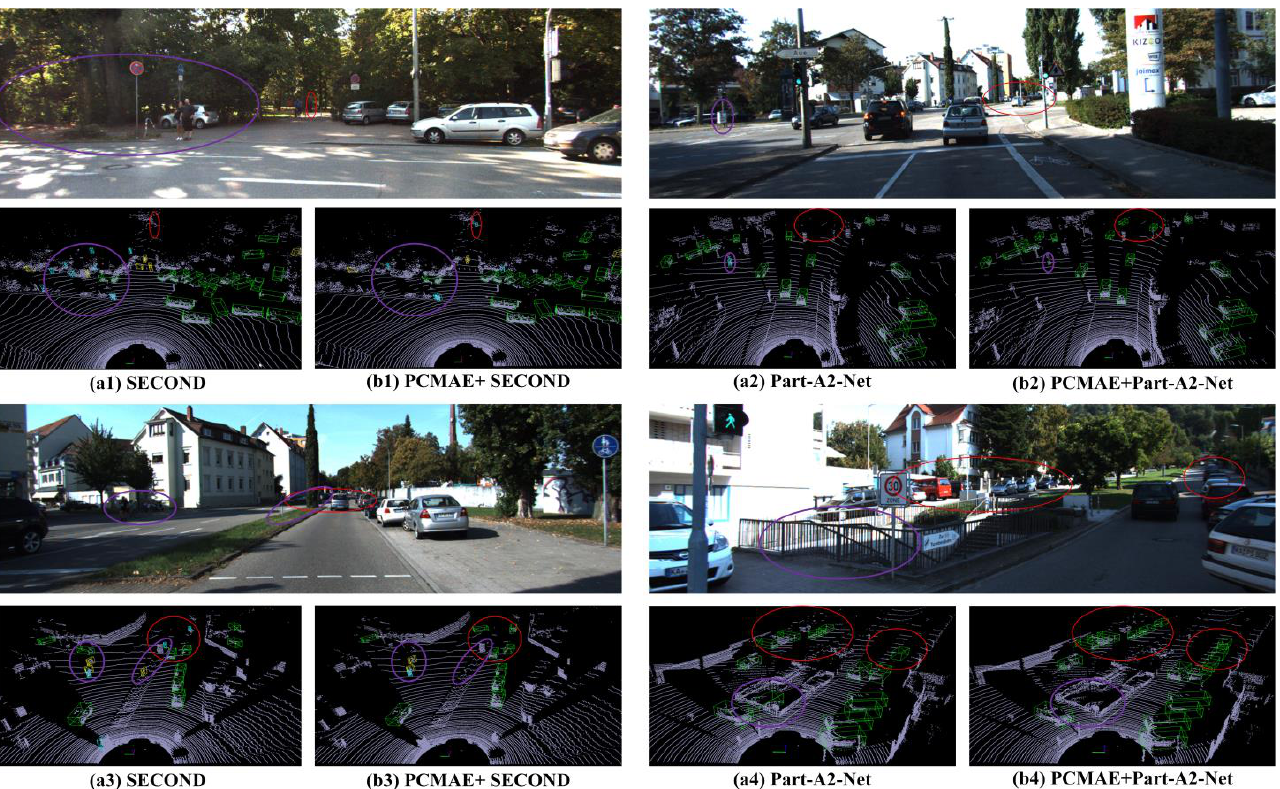
Figure 11. Qualitative results on the KITTI test set. ( a1 – a4 ) Detection results of the original algorithm. ( b1 – b4 ) The optimized algorithm detection results. Green boxes represent cars. Blue boxes represent pedestrians. Yellow boxes represent cyclists. Red ovals indicate missed detections. Purple ovals indicate false detections.